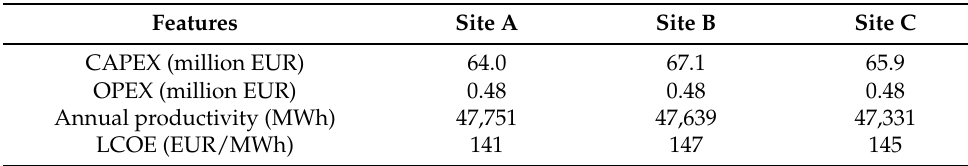
Table 13. Capex, Opex and LCOE for the three considered sites.